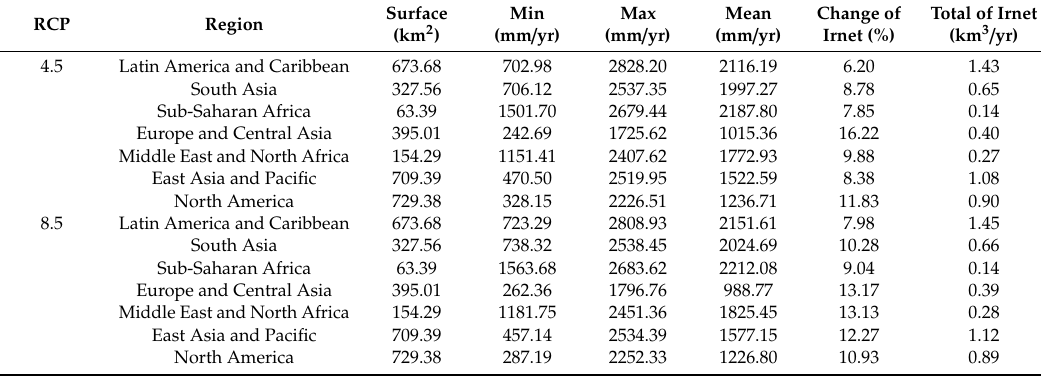
Table 3. ECHAM regional net irrigation water requirement.